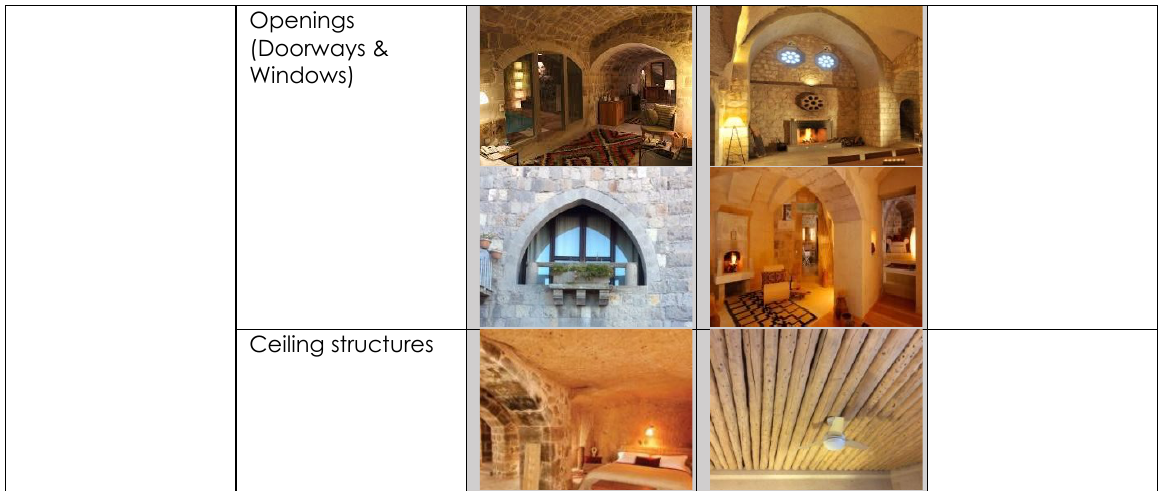
8. Taxonomy of Design Original Architectural / Interior Design Les Maison Cappadocia by Avizou Interior Level furnishing difference